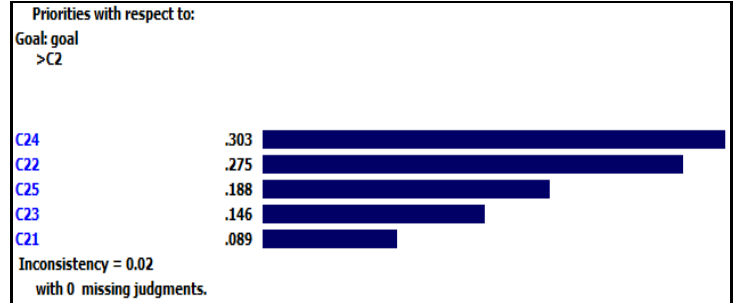
Fig. 5. Weights of sustainable marketing sub-criteria.